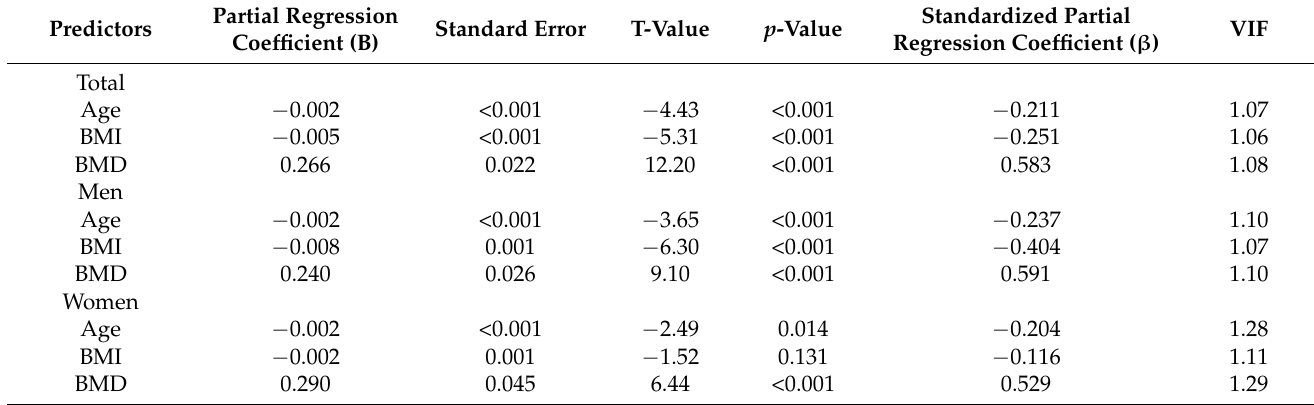
Table 4. Factors associated with trabecular bone score † .